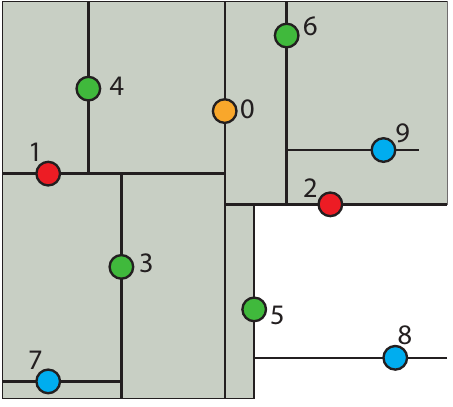
Figure 10. The half-space to the left of Node 5 is ignored when searching Node